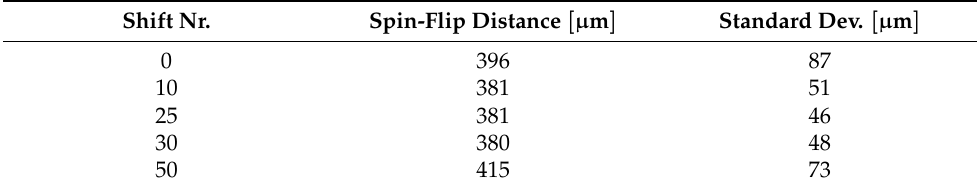
Table 1. Fringe pattern. Shift